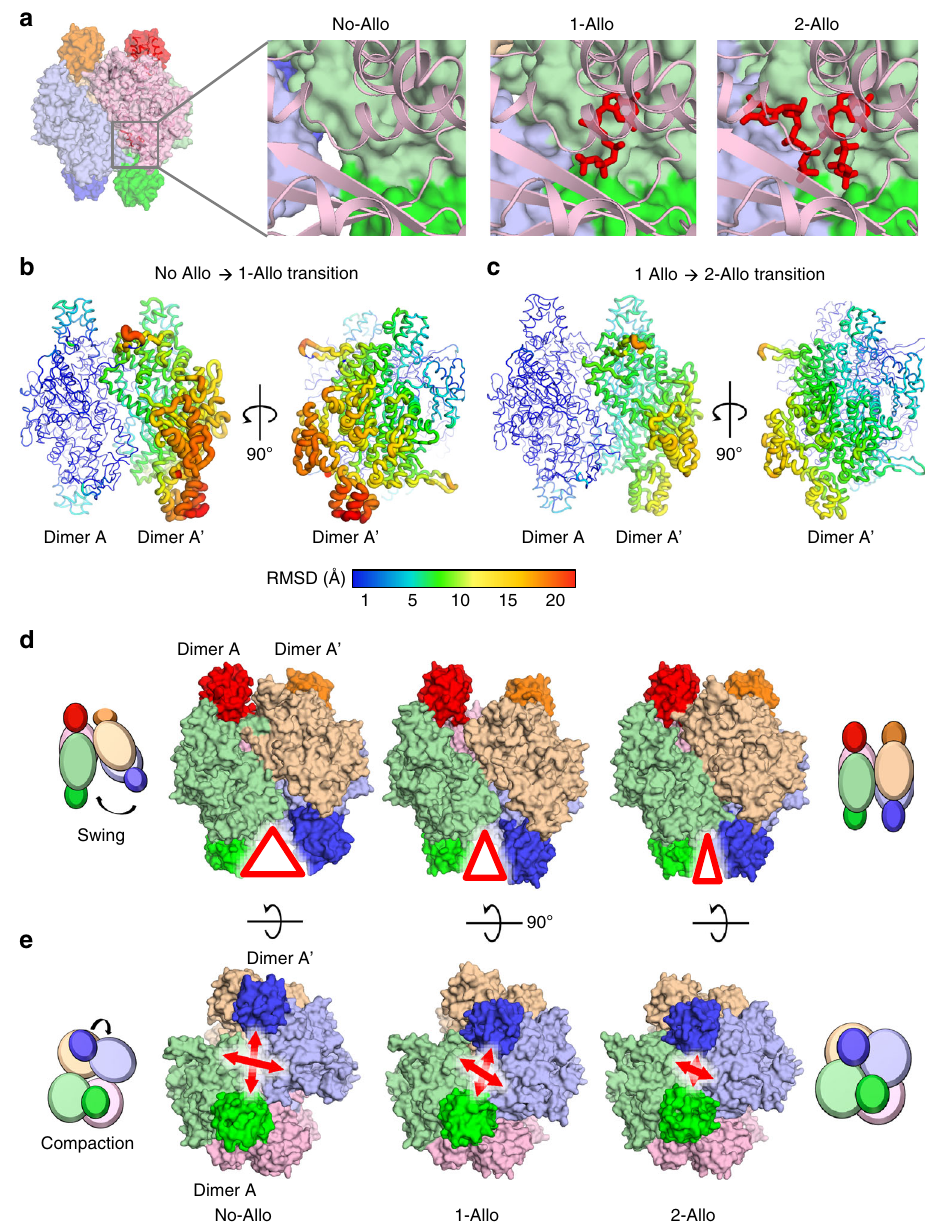
Fig. 4 Crystal structures of mSAMHD1 activation intermediates. a Surface and ribbon representations of the mSAMHD1 structures at the allosteric site. Nucleotides are shown in red sticks and each subunit is colored uniquely. Left, No-Allo structure with no nucleotides bound. Middle, 1-Allo structure with dGTP bound to Allo-site 1. Right, 2-Allo structure with GTP and dGTP bound to Allo-site 1 and Allo-site 2, respectively. b , c Putty representation comparing the No-Allo and 1-Allo mSAMHD1 structures ( b ) and comparing the 1-Allo and 2-Allo structures ( c ) in two orthogonal views. The structures are aligned by superposition of dimer A. RMSD values are represented using the color spectrum and the thickness of the coil. d , e Surface representation of the No-Allo (left), 1-Allo (middle), and 2-Allo (right) structures showing conformational differences. Red triangles and arrows highlight the separation between a pair of SAM domains (green and purple). Cartoon schematics of the No-Allo (left) and 2-Allo structures (right) indicate the swinging (top row) and compacting (bottom row) motions of dimer A ′ toward dimer A. Double-headed arrows highlight the distances between SAM domains as the tetramer becomes more